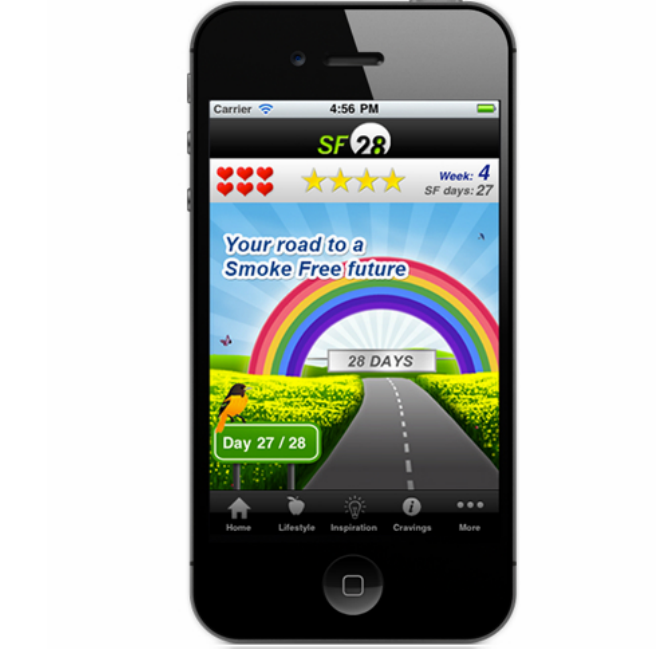
Figure 1. SF28 homescreen.